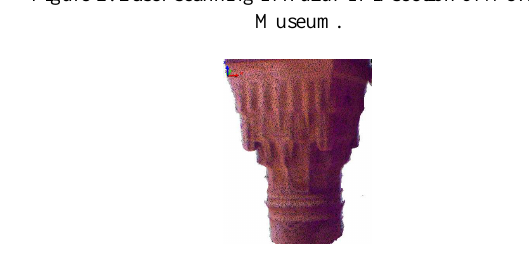
Figure 3. Point cloud of the column embellishment on the door of